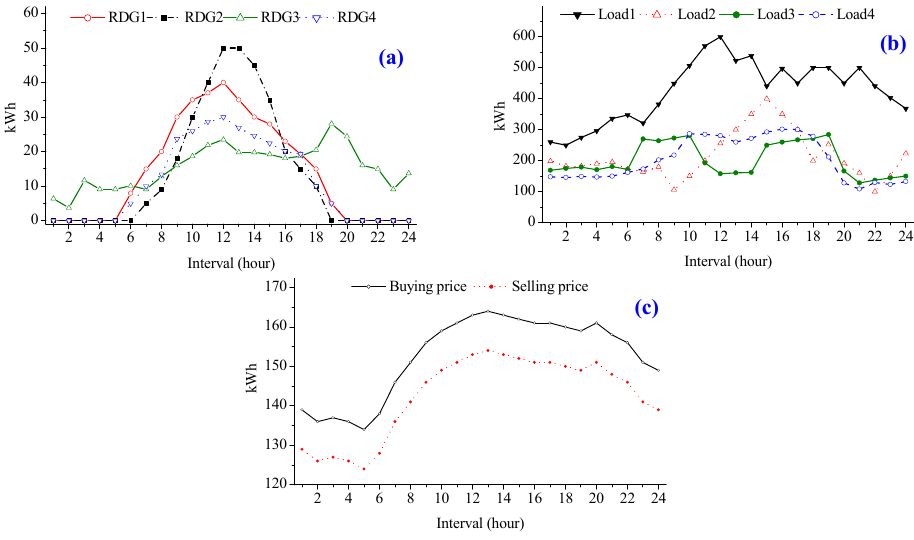
Figure 7. Input data: ( a ) renewable generations; ( b ) load amount; and ( c ) market price signals. Table 1. Parameters related to DG units and BESS of the microgrid system.